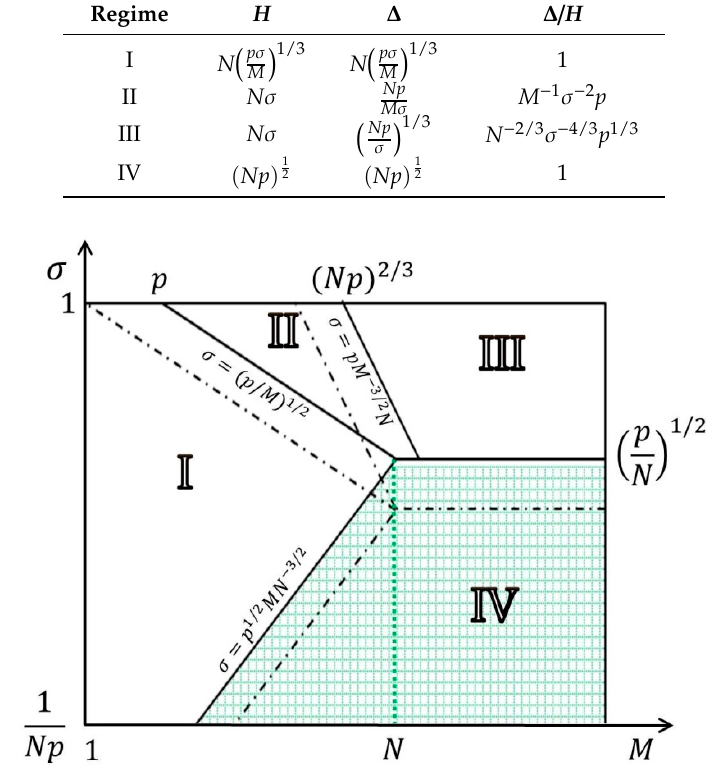
Table 1. Scaling power-law dependencies of the brush thickness H and the penetration length ∆ for di ff erent regimes of solvent penetration into the brush.